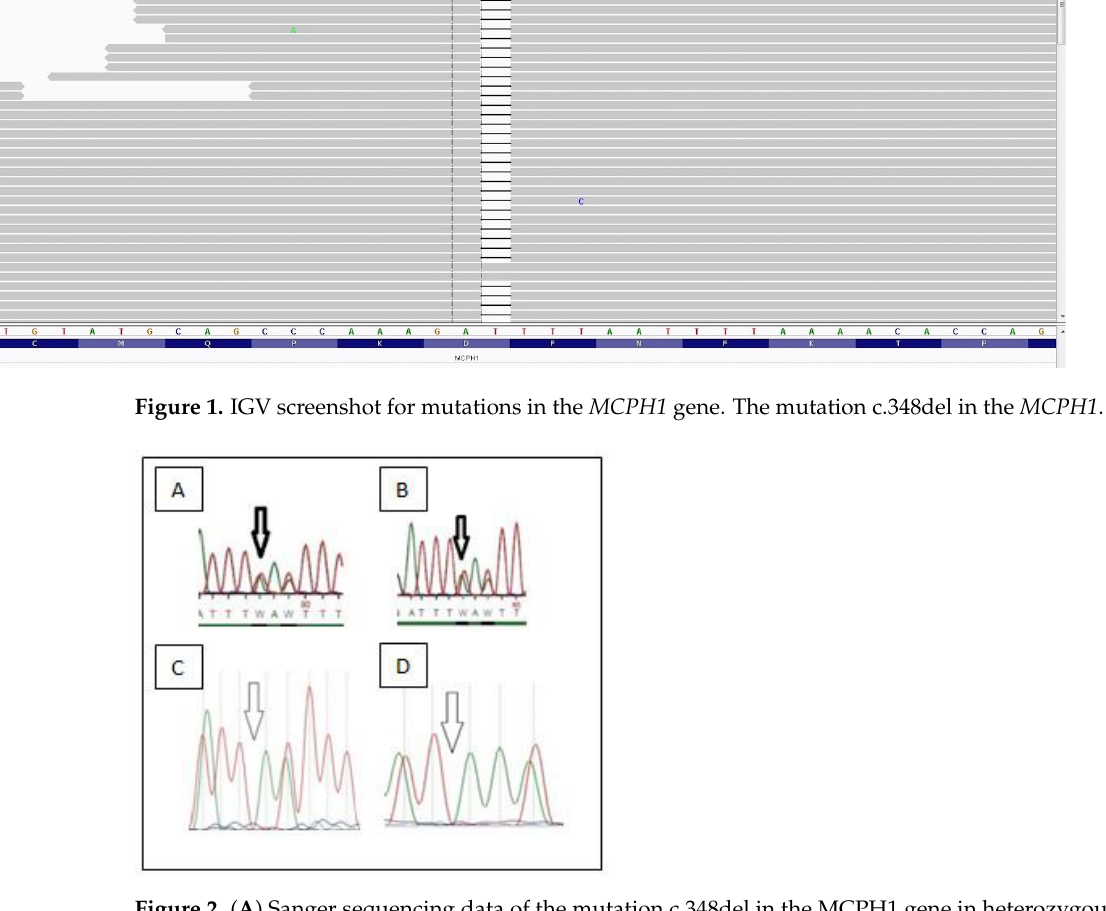
Figure 2. ( A ) Sanger sequencing data of the mutation c.348del in the MCPH1 gene in heterozygous